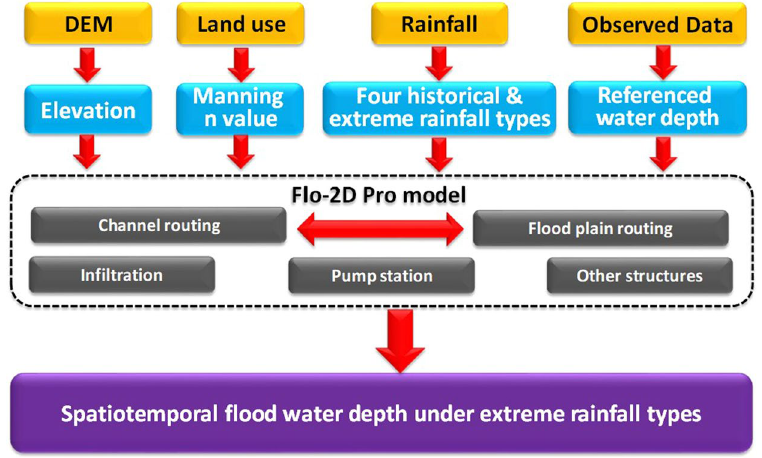
Figure 7. Frame work of flood inundation assessment under the historical and extreme rainfall in Hanoi central